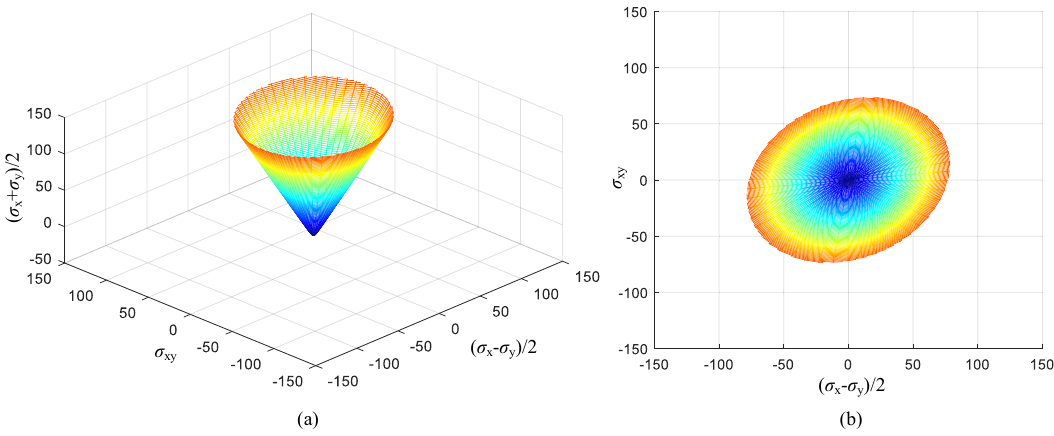
Figure 1. General yield surface: ( a ) three dimensional stress space [( σ x + σ y )/2, ( σ x − σ y )/2, σ xy ], and ( b ) the cross- section in the stress space of [( σ x − σ y )/2, σ xy